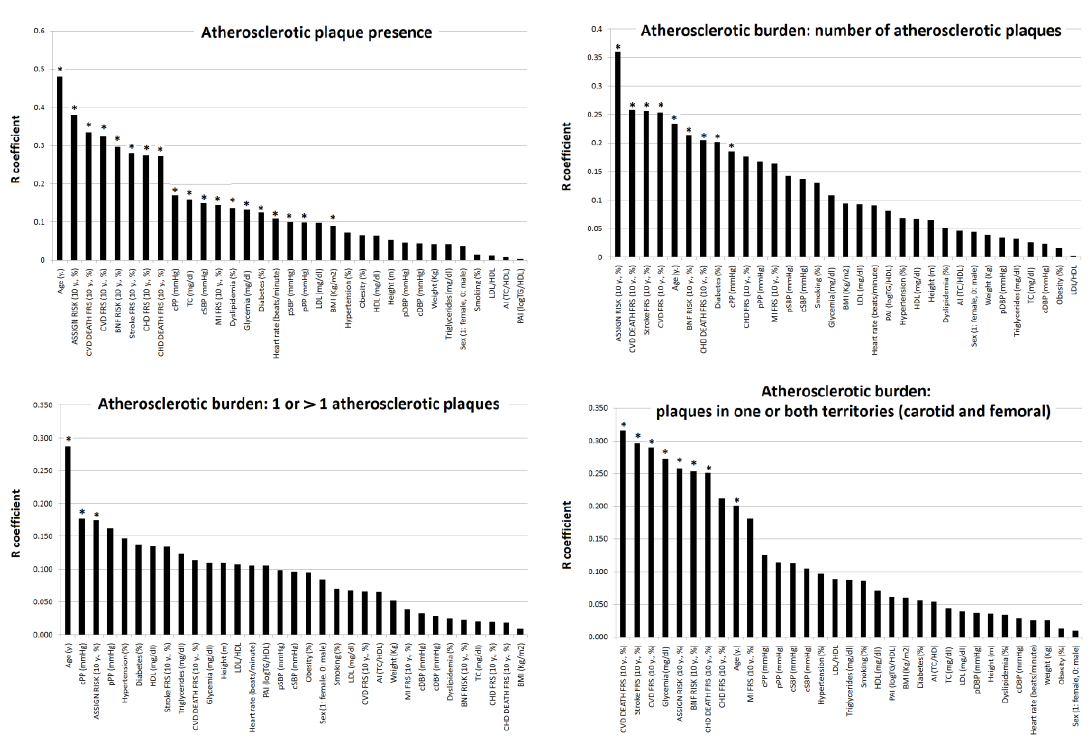
Figure 2. Strength of association (correlation coefficient absolute value, R) between subjects´ characteristics and plaques presence ( n = 581) or atherosclerotic burden ( n = 144). * p < 0.05.